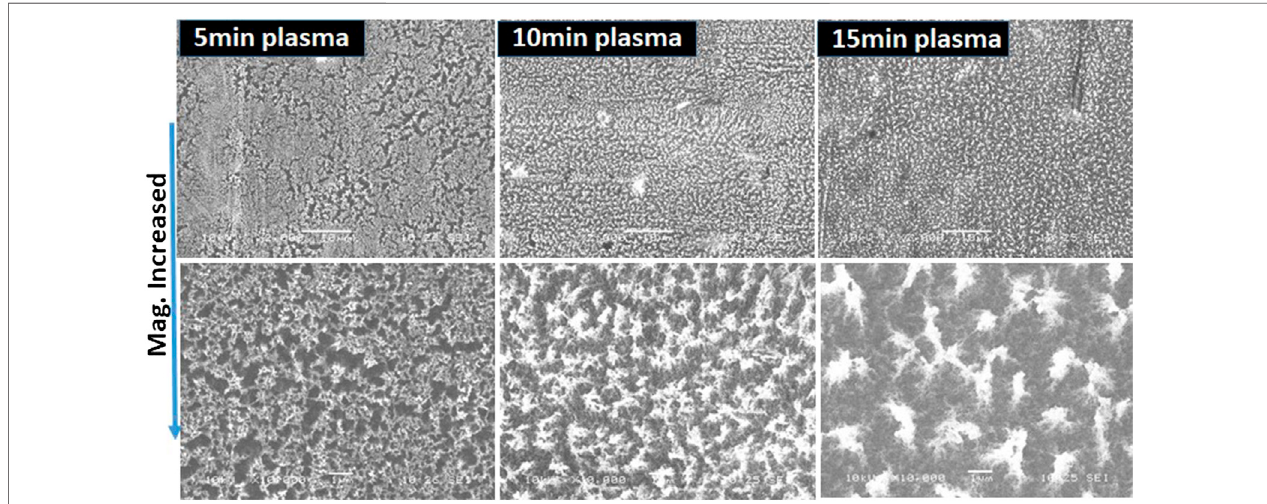
FIGURE 6 | Top view SEM images of VACNT layer: comparison of plasma treatment durations. (Scale bar on top (cid:2) 10 µm; Scale bar on bottom (cid:2) 1.0 µm).